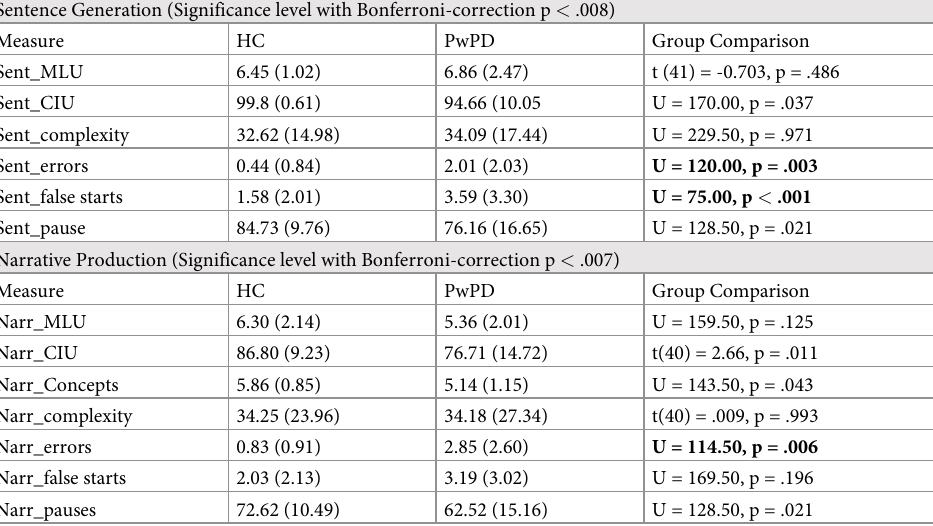
Table 5. Summary of group comparisons for the sentence generation and the narrative tasks providing descriptive data as well as statistical results. Results significant with Bonferroni corrections are marked in bold. Sentence Generation (Significance level with Bonferroni-correction p < .008)